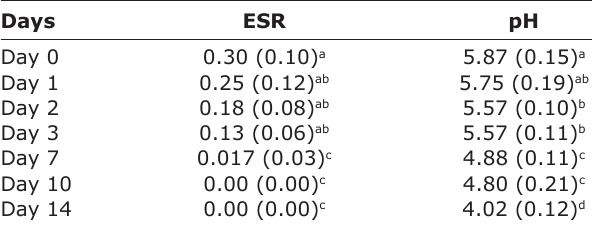
Table-3: Changes in the mean ESR and pH of CPDA-1 SCB at PS of blood. Days